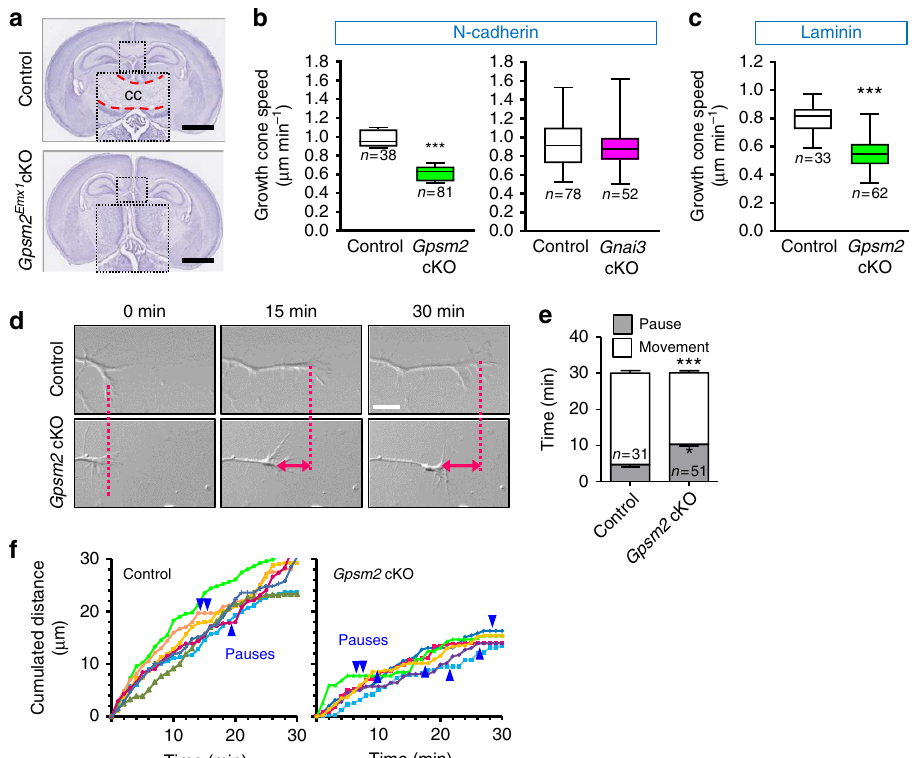
Figure 7 | Gpsm2 mutation leads to hypoplasia of the corpus callosum and affects growth cone outgrowth. ( a ) Hematoxylin staining of coronal sections from P6 Gpsm2 Emx1 control (upper panel) and cKO brains (lower panel) at a caudal levels. Note the abscence of corpus callossum (CC) in the cKO mouse (inset). Scale bar, 1mm, n ¼ 4 independent experiments. ( b , c ) In cultured hippocampal neurons at DIV2, N-cadherin-dependent outgrowth was reduced in Gpsm2 cKOs, but not in Gnai3 cKOs ( b ). The reduction in outgrowth was maintained on a laminin substrate in Gpsm2 cKOs ( c ). Data from three to six independent experiments are presented as whisker box plots (min/max) ( n ¼ number of growth cones). *** P o 0.001 with unpaired Student’s t -test. ( d ) Images from three time points (0, 15 and 30min) of a time-lapse movie from 2 DIVcontrol and Gpsm2 cKO hippocampal neurons plated on N-cadherin- coated glass and showing the difference in distance covered (dotted lines and double-headed arrows). Scale bar ¼ 10 m m. ( e ) Quantification of the average number of pauses ( ± s.e.m.) during a 30min period of growth cones from control ( n ¼ 31 neurons) compared with Gpsm2 cKO ( n ¼ 51 neurons), from four independent experiments. The Gpsm2 cKO growth cones pause more than controls. *** P o 0.001, * P o 0.05 with unpaired Student’s t -test. ( f ) Cumulated distance covered by control and Gpsm2 cKO growth cones over a 30min period. Some pauses are indicated with blue